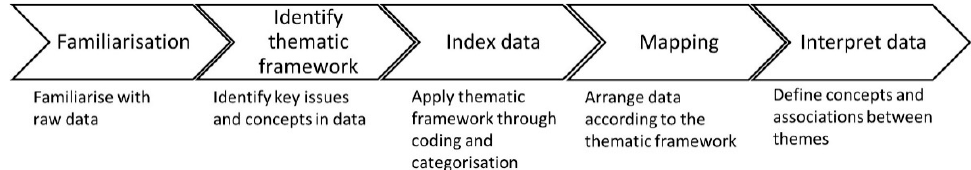
Figure 1. Stages of data analysis in the qualitative framework approach [50,51].